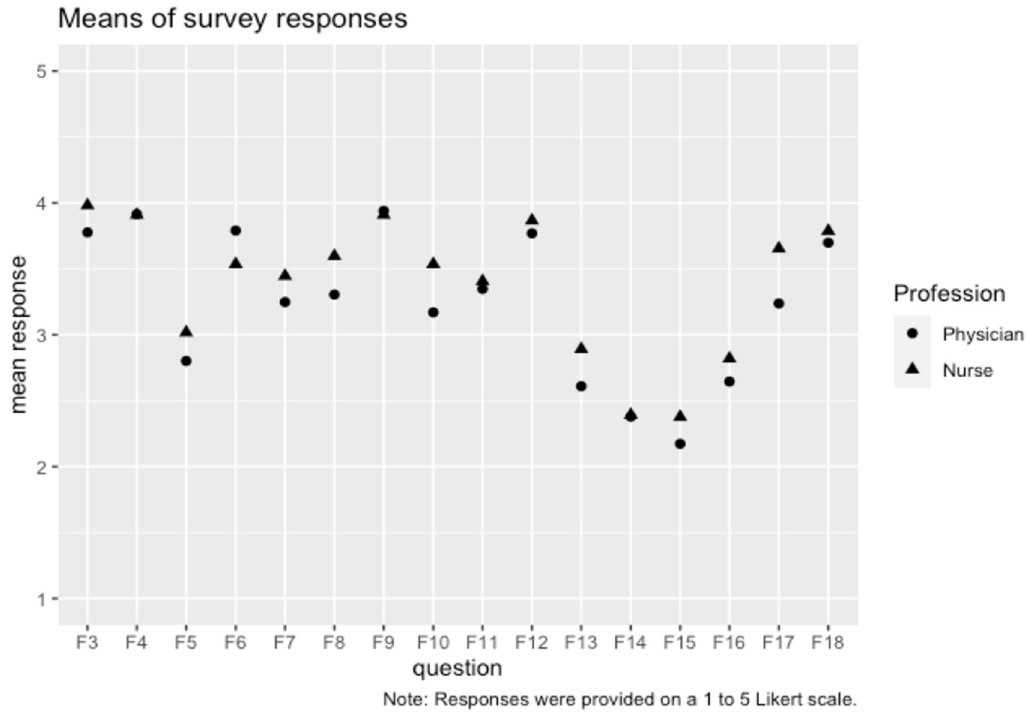
Fig 1. Means of survey responses for the physicians and the